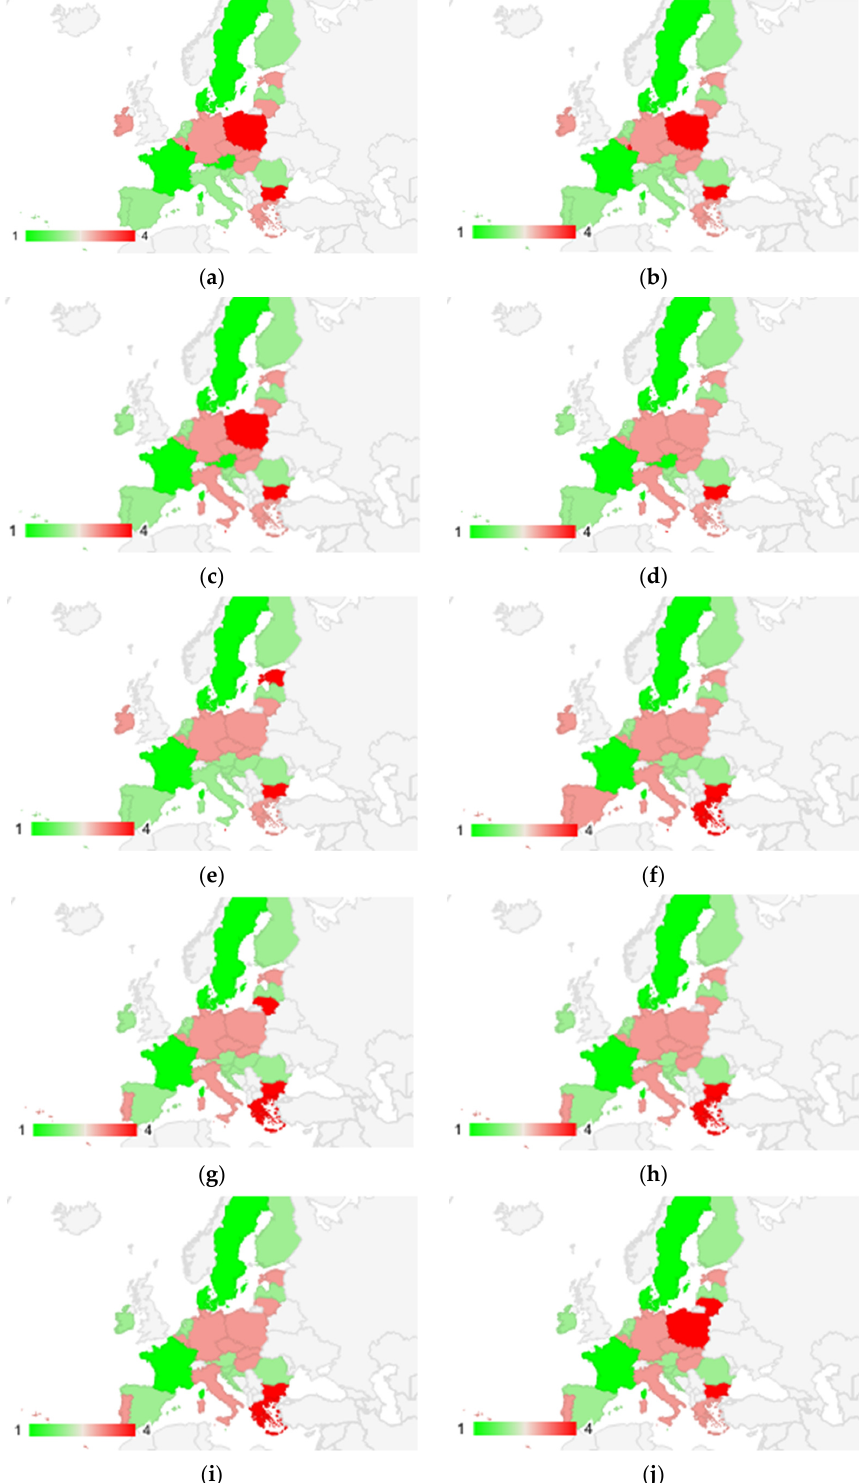
Figure 4. The classification of the EU countries in terms of the level of energy and climate sustainable development ( a —2009, b —2010, c —2011, d —2012, e —2013, f —2014, g —2015, h —2016, i —2017, and j